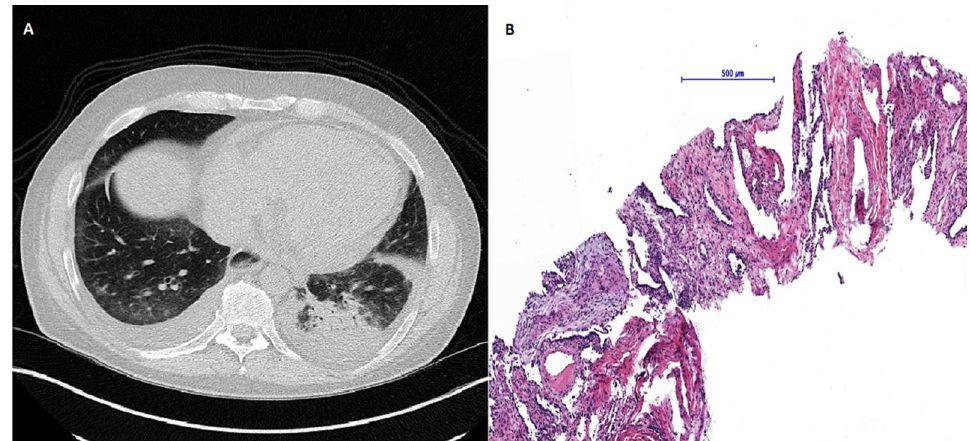
Figure 2. ( A ) High-resolution computed tomography of the lungs revealed ground glass opacities in both lower lobes with a consolidation in the left lower lobe. ( B ) Histological presentation of changed lung parenchyma. Needle biopsy sample of lung parenchyma showed broad interalveolar septae with fibrous tissue and chronic inflammatory cells as well as reactive changed type 2 pneumocytes. Lower left part of the sample demonstrates merging epithelioid cell granulomas without necrosis within myofibroblastic proliferation.